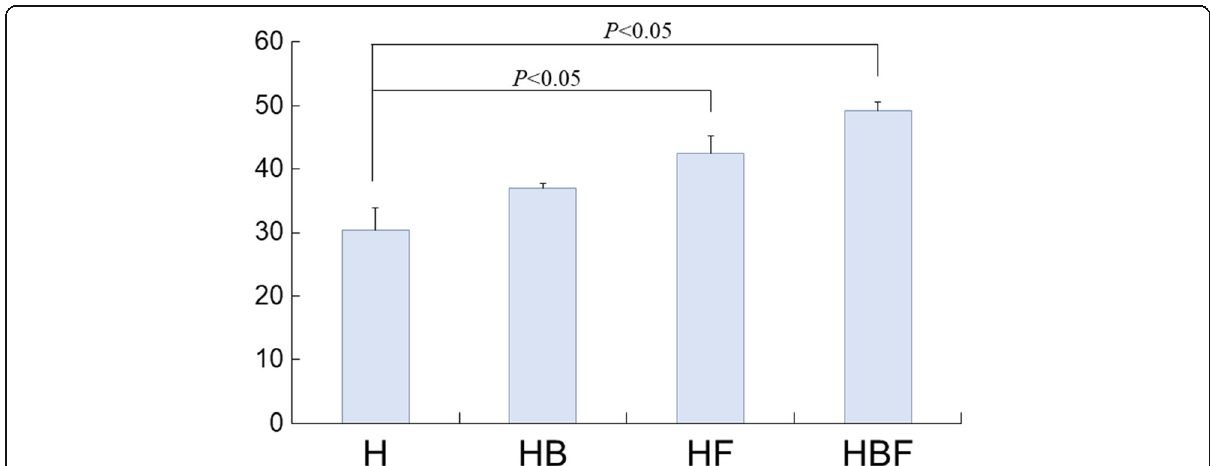
Fig. 6 Soft tissue histomorphometry of the hydrogel groups. The amount of newly formed soft tissue was significantly higher in the hydrogel combined with fibroblasts (HF) and hydrogel mixed with bFGF and fibroblasts (HBF) groups compared with that in the hydrogel (H) group ( p